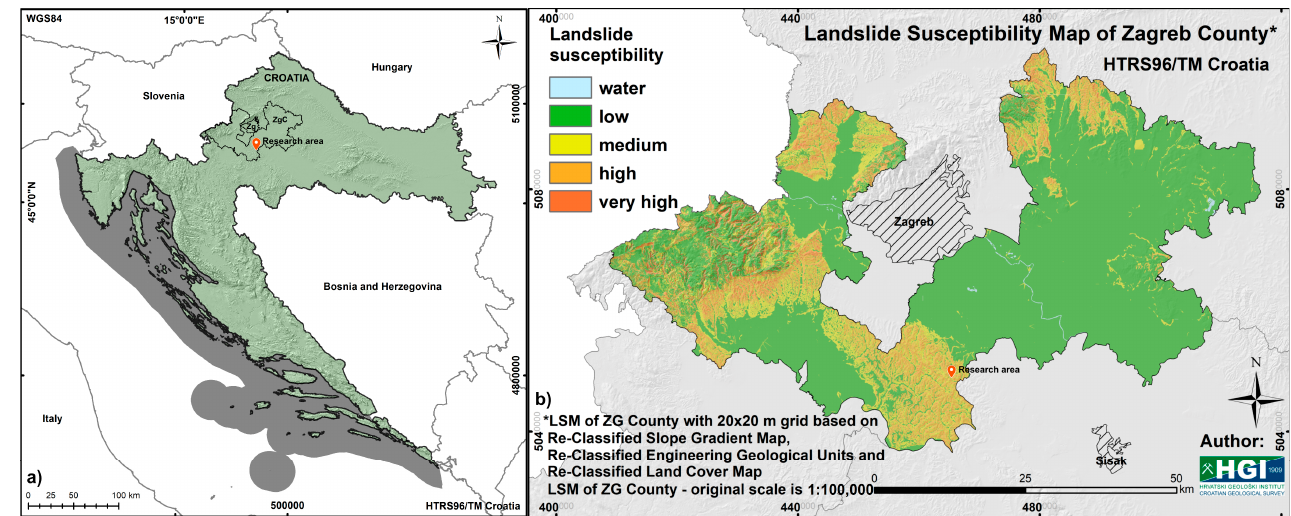
Figure 1. Research area location: ( a ) in northern Croatia south of Zagreb city (Zg) in Zagreb County (ZgC); ( b ) Landslide susceptibility map of Zagreb County, where the research area is found within the zones with medium to high landslide susceptibility [17].